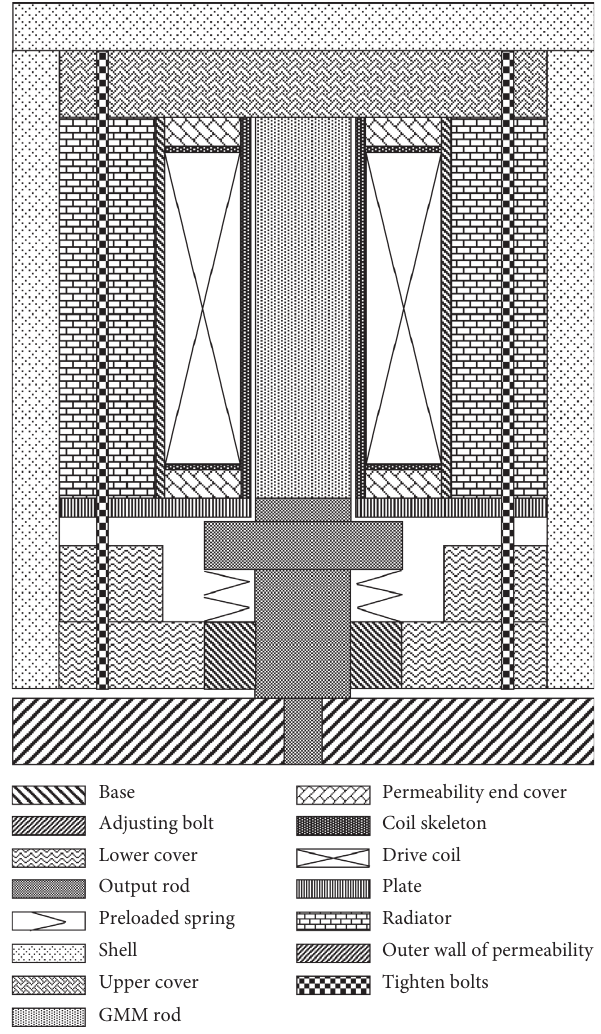
Figure 1: Overall structure of the GMV.